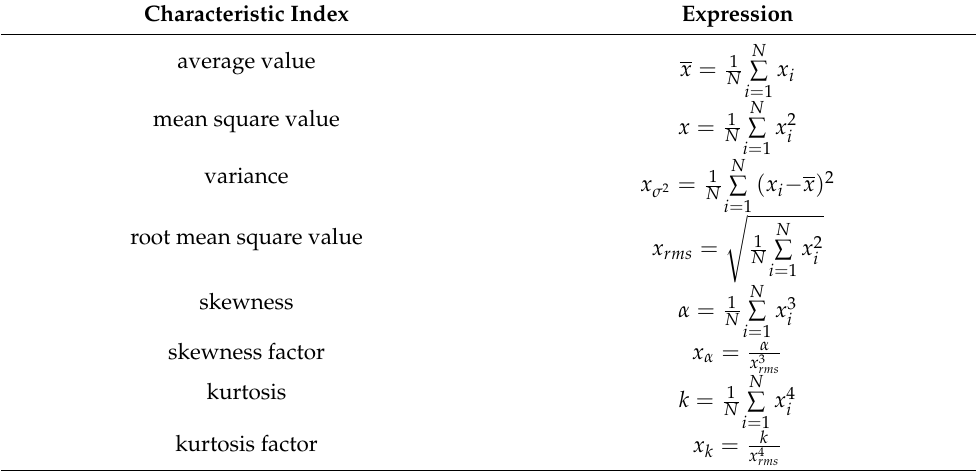
Table 6. Time domain characteristic